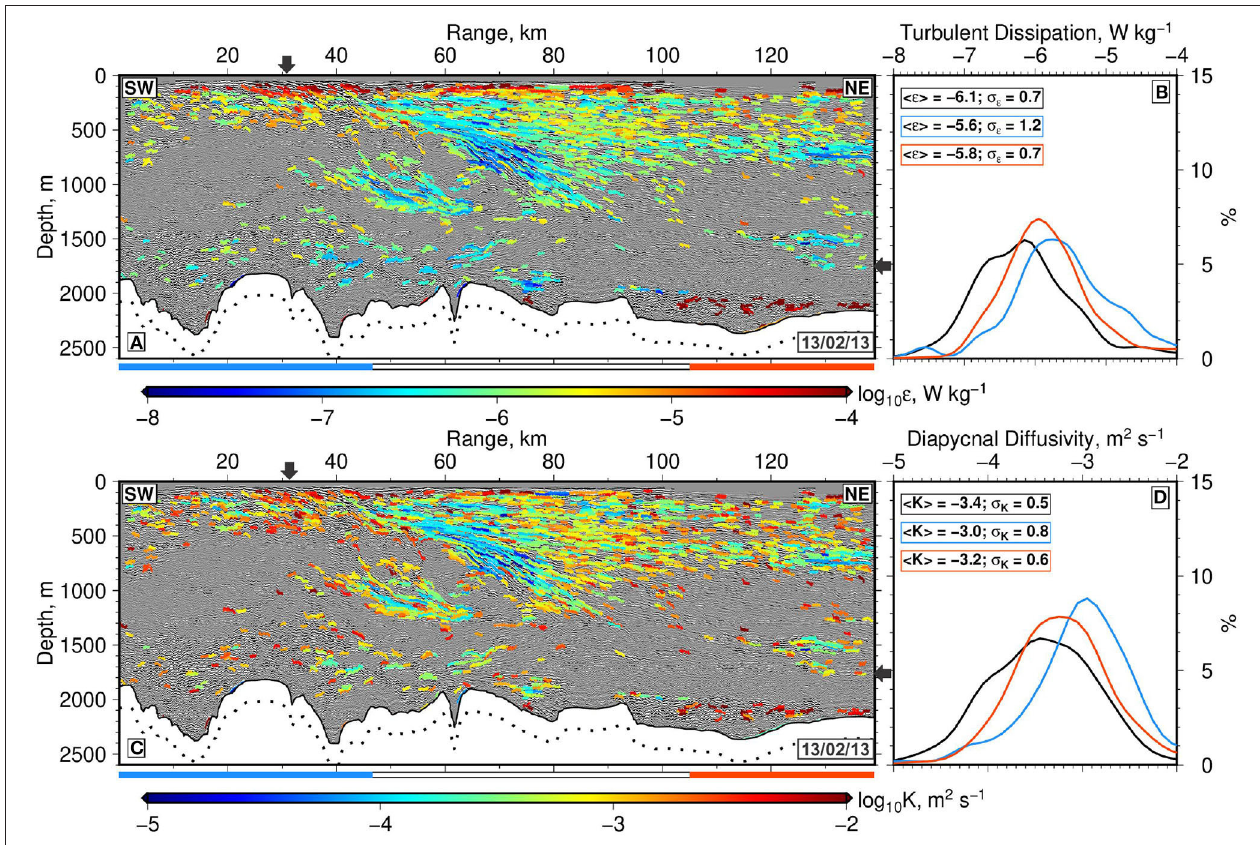
FIGURE 6 | (A) Spatial variation of turbulent dissipation rate, log 10 ε , for section B where warm/cool colors indicate higher/lower values according to scale bar along base of panel; black arrows = maximal extent of front at sea surface and at depth. (B) Histogram showing spatially averaged distribution of dissipation, <ε> . Envelopes calculated using bin widths of 0.1 and Gaussian filter lengths of 1 for spatial ranges of 0–40 (blue), 40–90 (black line and white bar), and 90–140 km (red). (C,D) Same for spatial variation of diapycnal mixing, log 10 K and its average value, < K > .